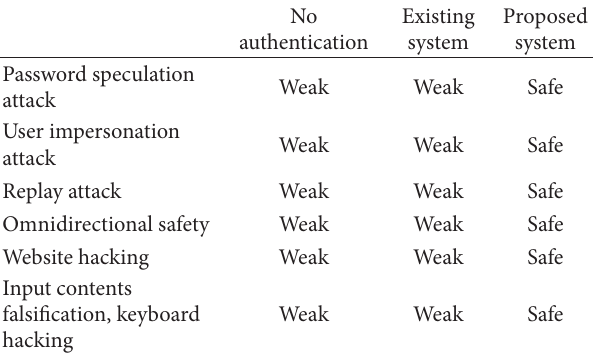
Table 3: Comparative analysis of